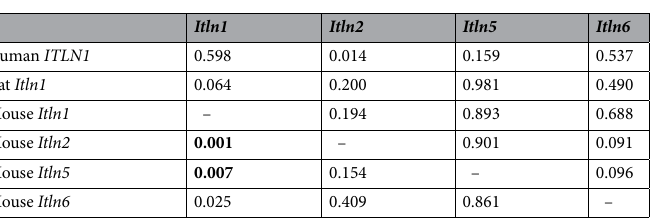
Table 2. McDonald-Kreitman analysis of mouse Itln genes. P values are shown indicating the comparison between the ratio of nonsynonymous to synonymous codon variations within the four Itln genes (columns) against divergence across species and with paralogues (rows). For example, the top left p value of 0.598 represents the comparison of variation within mouse Itln1 compared to divergence between mouse Itln1 and human ITLN1 . Statistically significant values with a false discovery rate of < 10% are shown in bold.